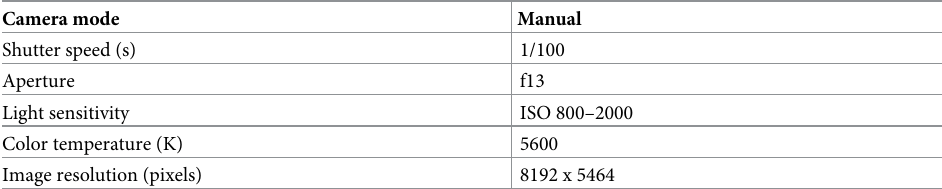
Table 2. Configuration of the camera Canon EOS R5 for image capturing.